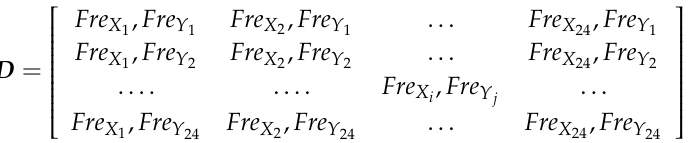
Figure 4. Diagram of the DTW distance function considering the time window (DTW, dynamic time warping).